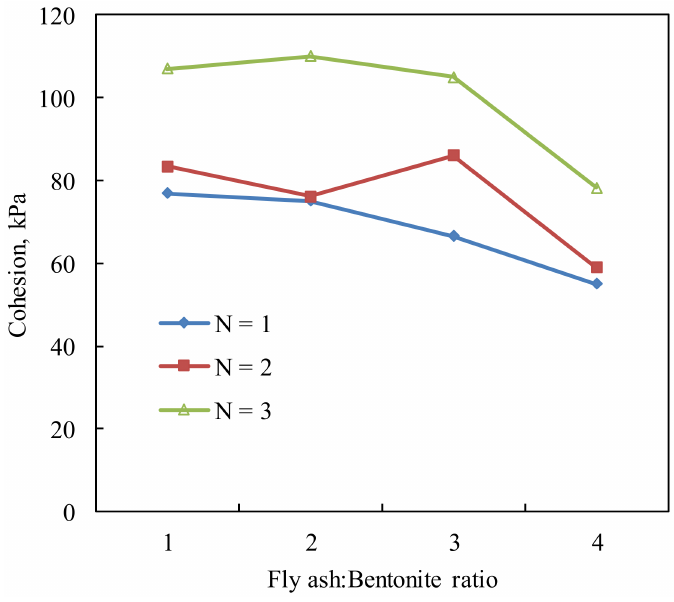
Figure 10. Effective cohesion values against fly ash–bentonite